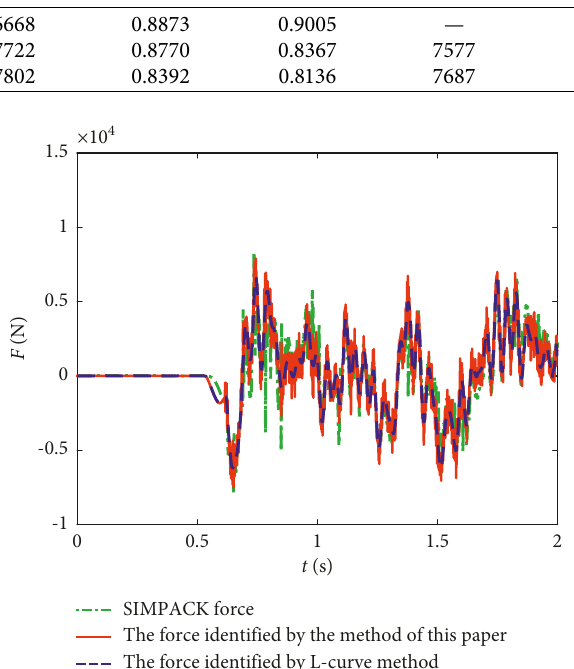
2 identification when the noise level is